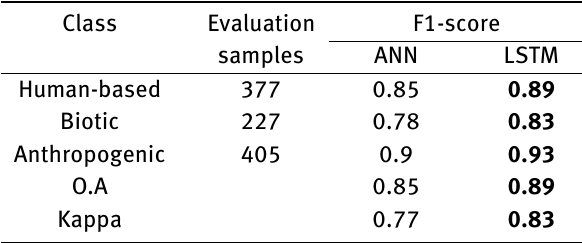
Table 4: Class-wise model performance of 3-class